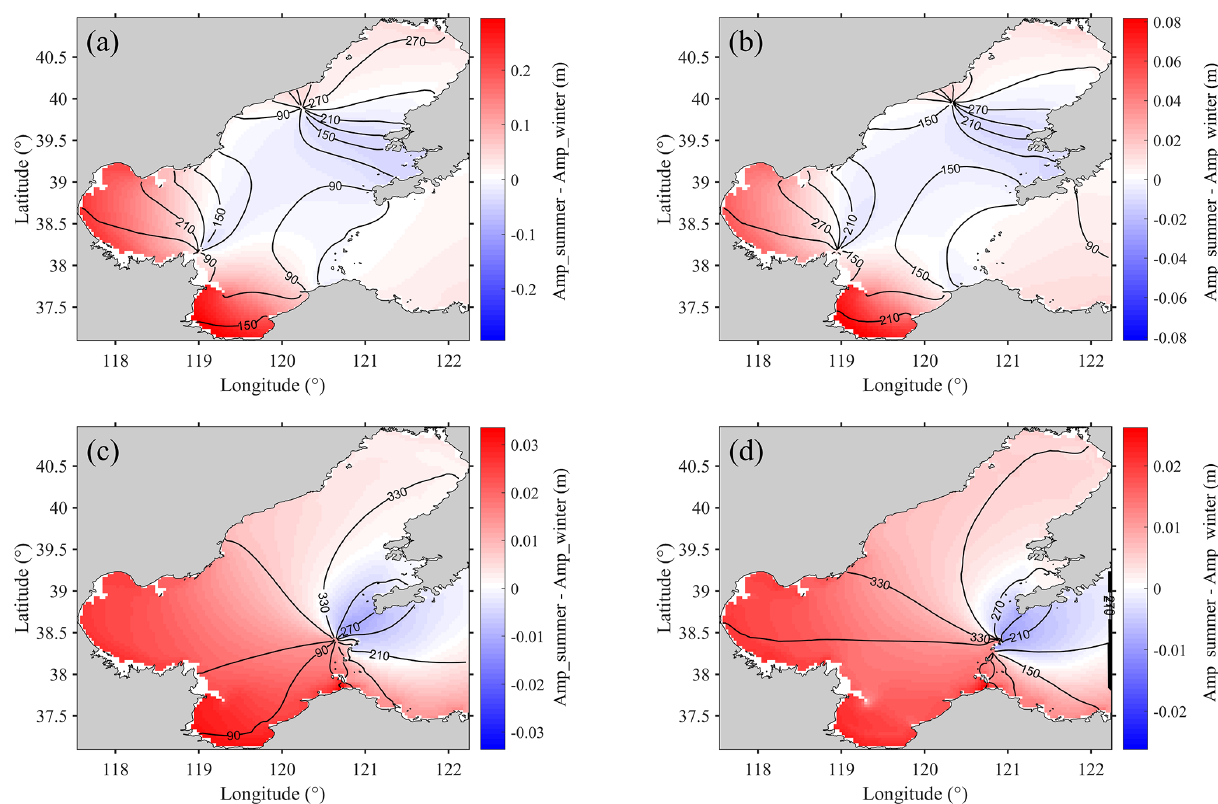
Figure 10. (a) Difference between the simulated M 2 amplitudes in summer (Exp3) and those in winter (Exp1) (colours) and the co-phase lines of the M 2 tide in winter (Exp1) (black lines). Panels (b) – (d) similar to (a) but for S 2 , K 1 and O 1 ,